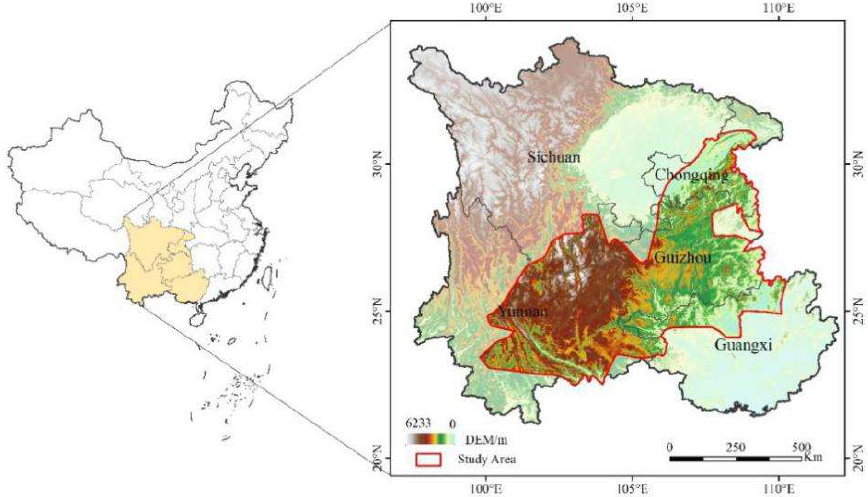
Figure 1. Location of study area (circled with the red polygon).